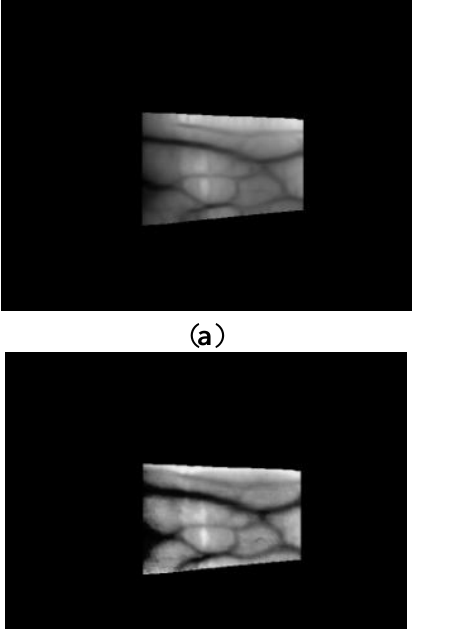
Figure 20. Enhanced images produced using the proposed method with four-directional Gabor filtering and Retinex filtering with a sigma value of 20 based on an image